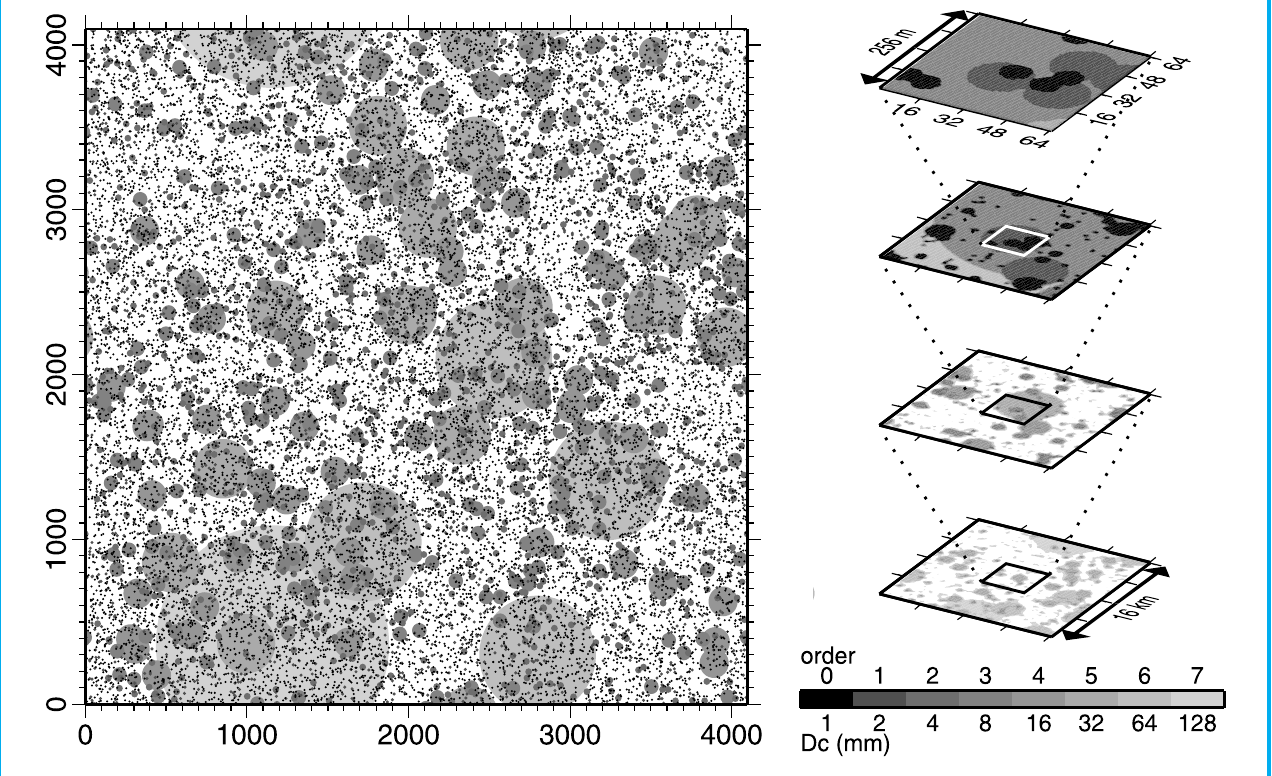
Figure 2. Distribution of circular patches (from Ide and Aochi,